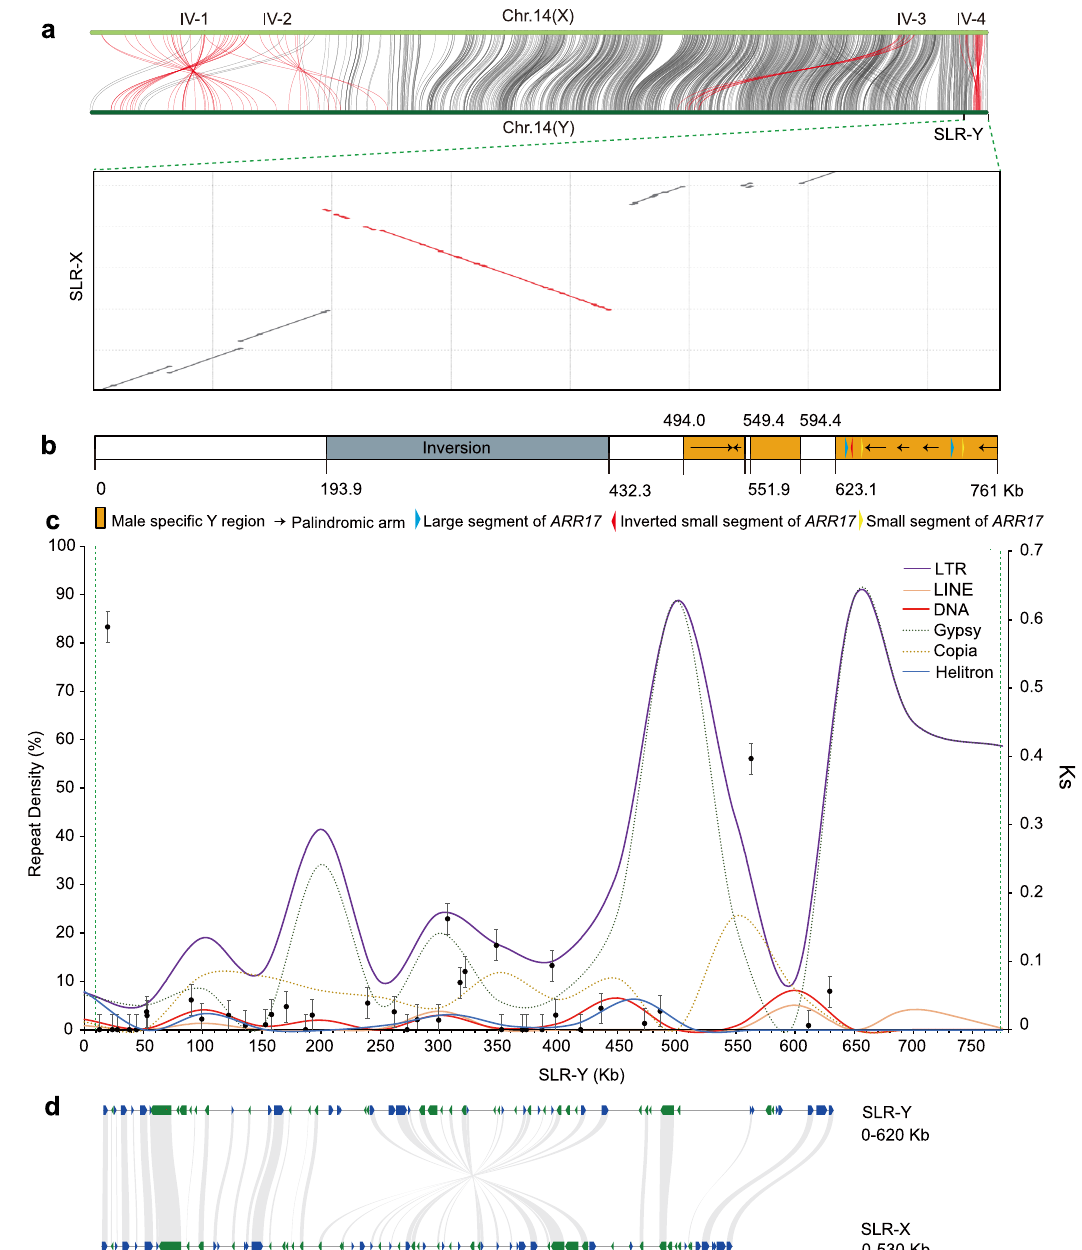
Fig. 3 Structural and sequence characteristics of SLR on chromosome 14 in P. euphratica . a Synteny plot between the X and Y chromosomes, including SLR-Y and the counterpart region SLR-X. Four inversed fragments (IV-1, 2, 3, and 4) were marked in red. b Structural variation at SLR-Y. c Repeat types and repeat density in SLR-Y, and Ks of homolog gene pairs between SLR-Y and SLR-X. d Colinearity between genes from SLR-Y and